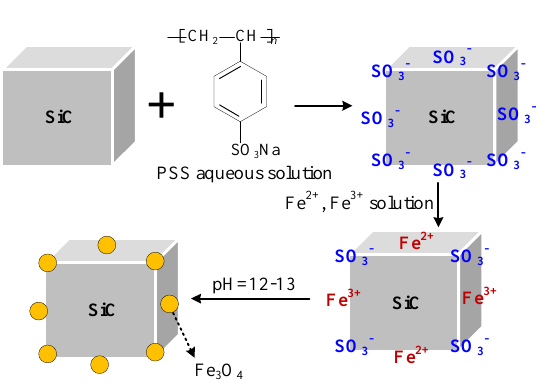
Figure 1. Synthesis process of Fe 3 O 4 -coated SiC. The preparation process of the magnetic SiC (M-SiC) is illustrated in Figure 2.